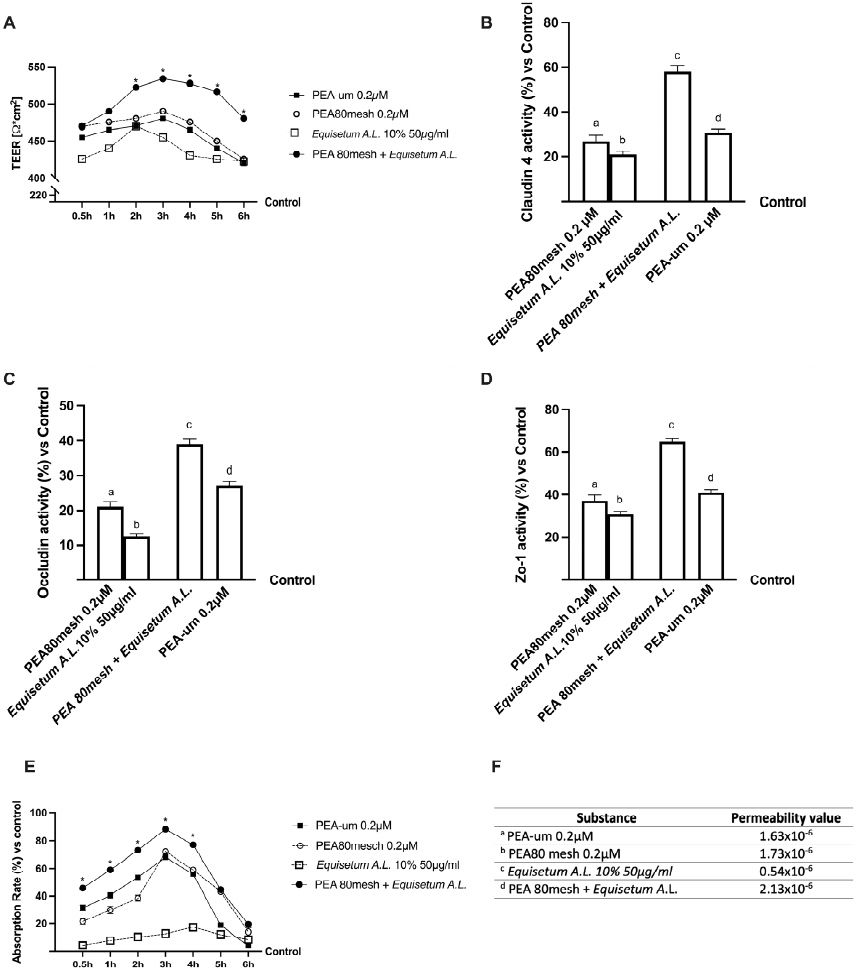
Figure 1. Permeability study on CaCo-2 cells. In ( A ) TEER Value using EVOM3; from ( B – D ) the analysis of TJ measured by ELISA test (Claudin1, Occludin and Human Tight Junction Protein 1 (Zo-1), respectively); in ( E ) evaluation of passage through the intestinal barrier by fluorescent tracer; in ( F ): the Papp values in which data < 0.2 × 10 − 6 cm/s means very poor absorption with a bioavailability < 1%, data between 0.2 × 10 − 6 and 2 × 10 − 6 cm/s with bioavailability between 1 and 90%, and data > 2 × 10 − 6 cm/s means very good absorption with a bioavailability over 90%. Equisetum A.L. = Equisetum arvense L.; PEA-um = PEA ultra-micronized. From ( B – E ) data are the means ± SD (%) of five independent experiments performed in triplicate and normalized to control values (the 0% line). PEA-um = ultra-micronized PEA. In ( A ): * p < 0.05 vs. PEA80mesh 0.2 µM. In ( B ): a–d p < 0.05 vs. control; a p < 0.05 vs. b, c; b p < 0.05 vs. c, d; c p < 0.05 vs. d. In ( C ): a–d p < 0.05 vs. control; a p < 0.05 vs. b–d; b p < 0.05 vs. c, d; c p < 0.05 vs. d. In ( D ): a–d p < 0.05 vs. control; a p < 0.05 vs. b, c; b p < 0.05 vs. c, d; c p < 0.05 vs. d. In ( E ): * p < 0.05 vs. PEA80mesh 0.2 µ M. In ( F ): a p < 0.05 vs. c, d; b p < 0.05 vs. c, d; c p < 0.05 vs.